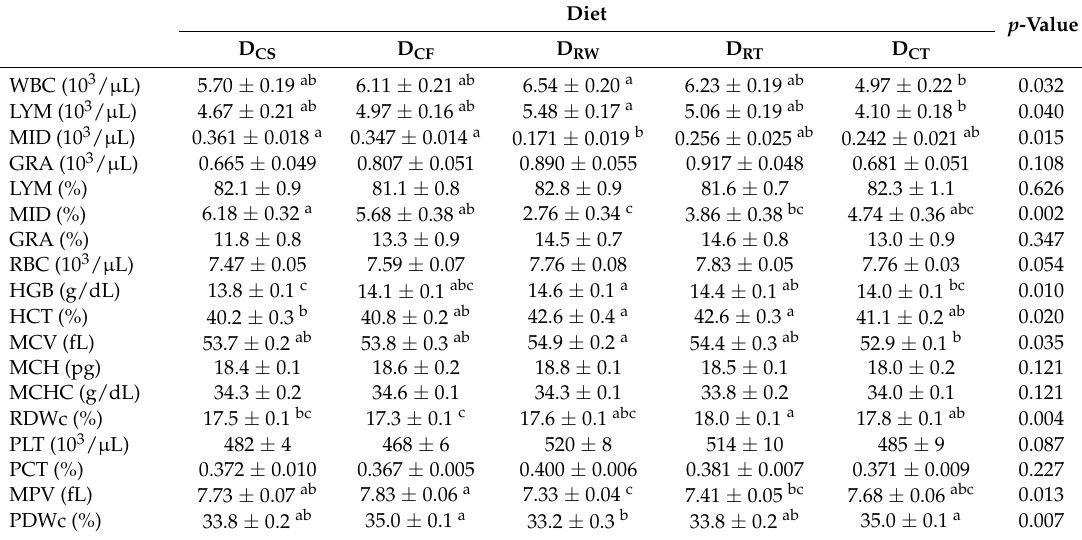
Table 5. Hematological parameters in rats. Data are expressed as mean ± SEM, n =